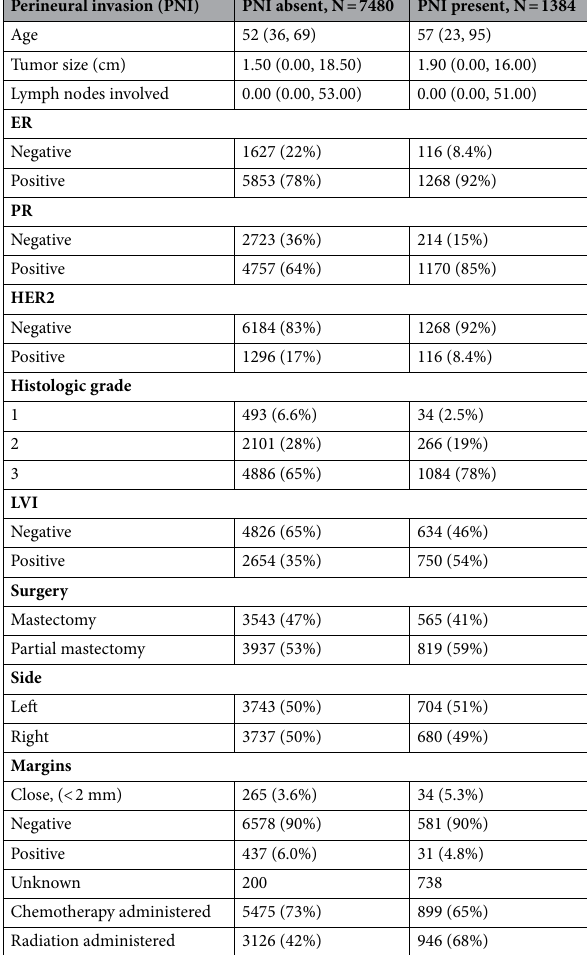
Table 1. Patient and treatment characteristics. Statistics presented: median (range); n (%).